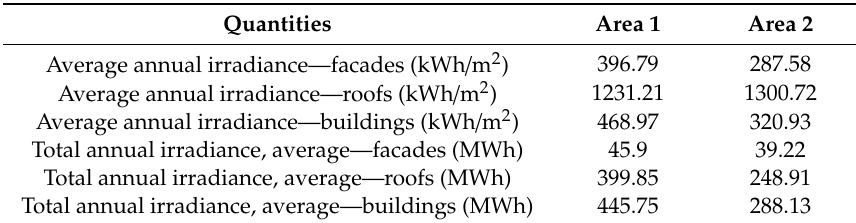
Table 3. Annual irradiation averages and totals for areas 1 and